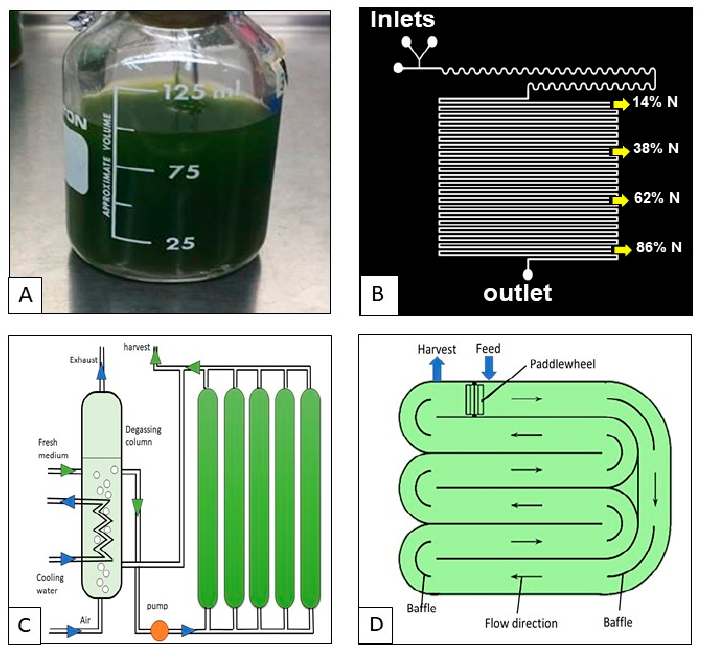
Figure 3. Algal cultivation techniques. ( A ) Conventional method ( in vitro ), ( B ) Lab on-a-chip method ( in vitro ), ( C ) Photobioreactor ( in vivo ), and ( D ) Open pond ( in vivo ).